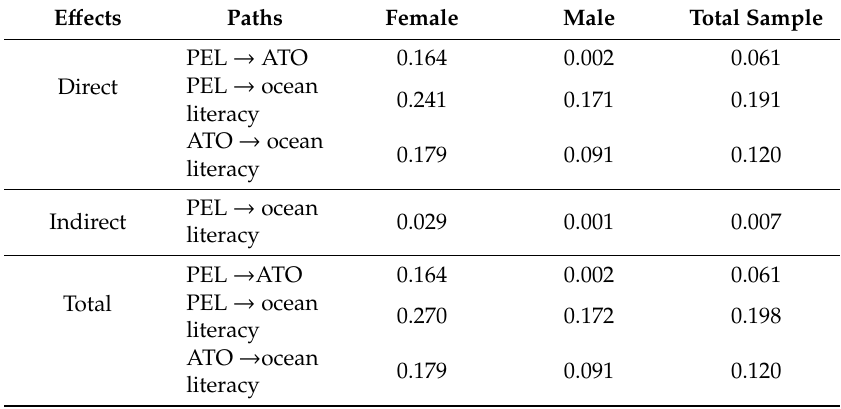
Table 3. Direct, indirect, and total e ff ects of latent variables on ocean literacy. E ff ects Paths Female Male Total Sample PEL → ATO 0.164 0.002 0.061 PEL → ocean Direct 0.241 0.171 0.191 literacy ATO → ocean 0.179 literacy